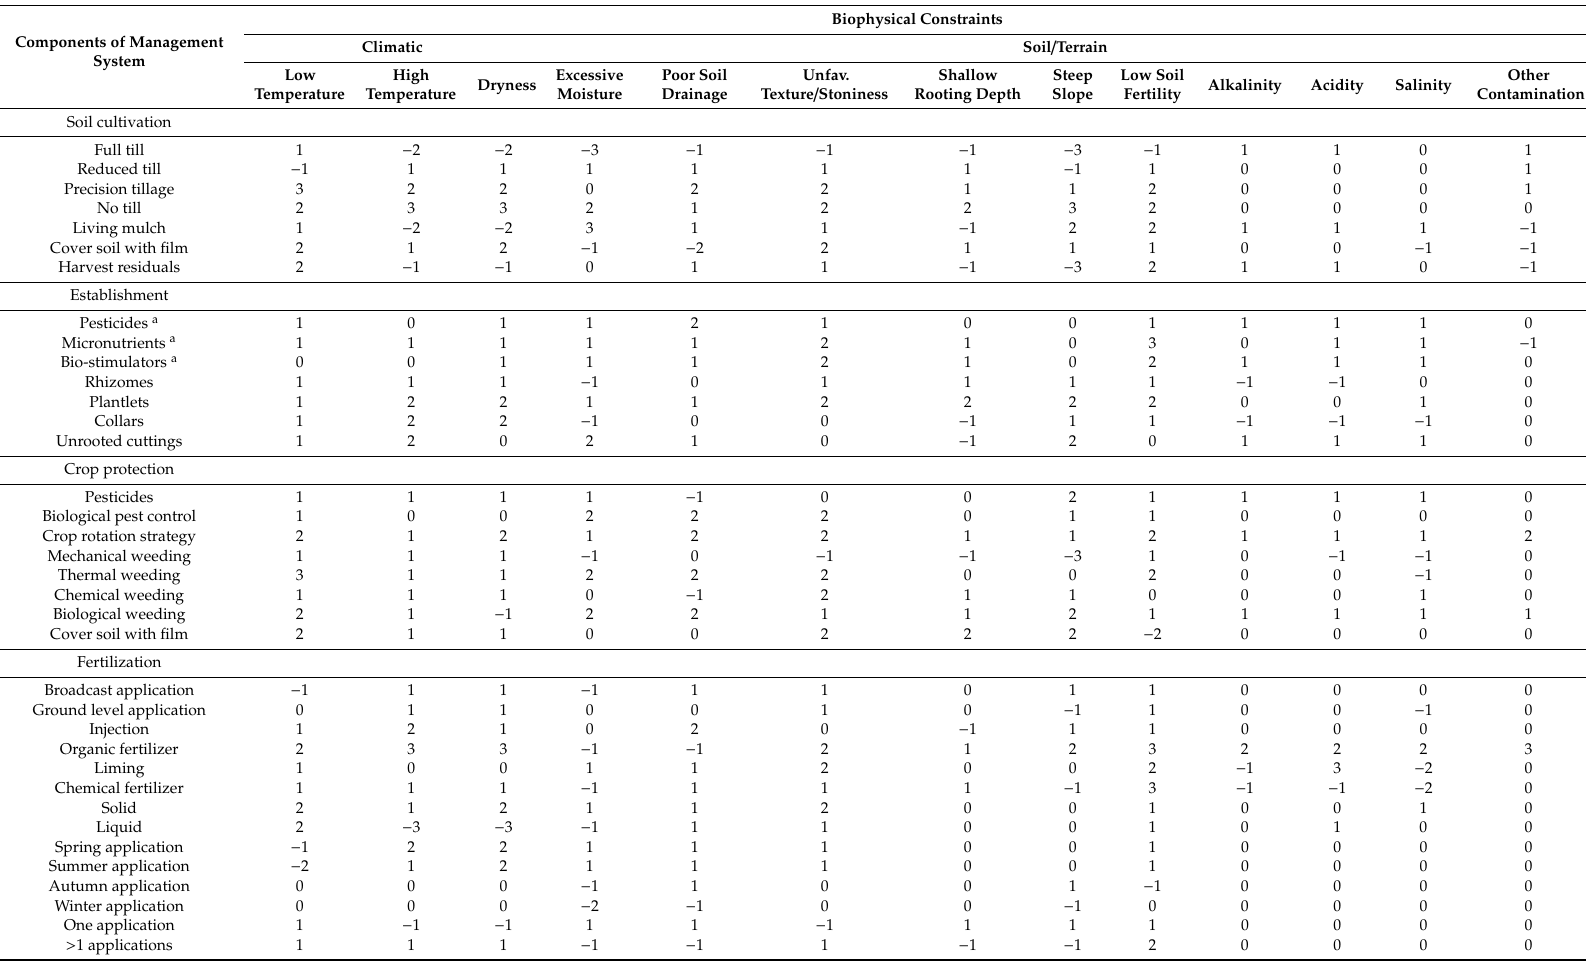
Table A5. Suitability ranking of selected components of agricultural management systems for competing with the prevailing biophysical constraints on